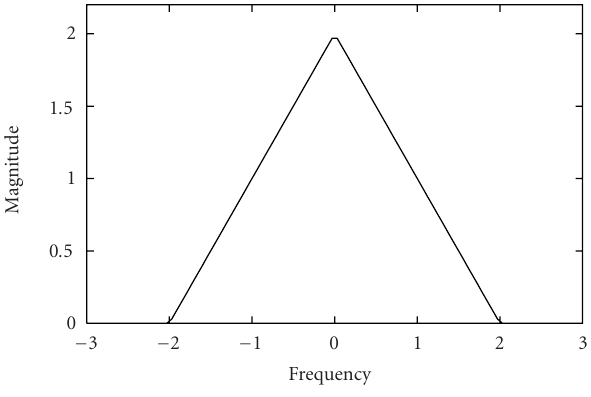
Figure 4.5. Spectrum of sinc-square function.